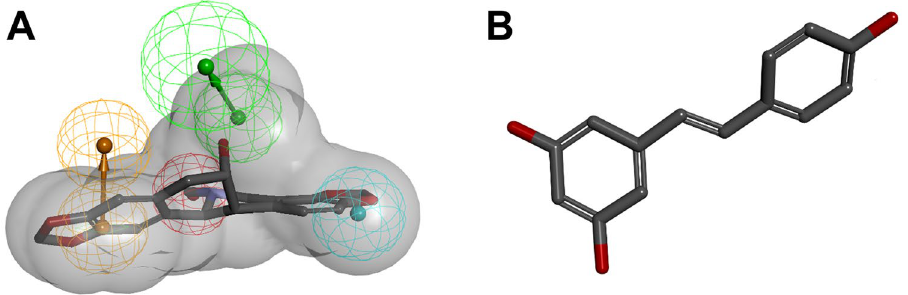
Figure 9. Comparison of the pharmacophore model for CYP2D6 inhibitors with a structurally diverse compound. ( A ) The newly identified compound 21 was found by the model and thus shares the necessary features to act as a strong inhibitor in the CYP2D6 assay. ( B ) 24 is structurally diverse and does not fit into the model, but exhibits an intermediate inhibitory potential on CYP2D6 mainly by interacting with the detection reaction. While it also has aromatic, hydrophobic and hydrogen bonding features, the lack of a positively ionisable nitrogen is obviously contributing to the actual inactivity of 24